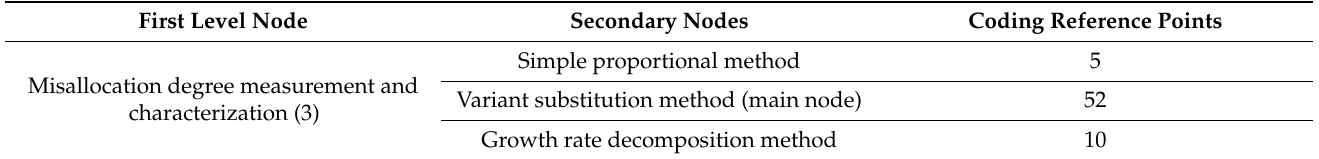
Table 7. Number of nodes at all levels and coding reference points included in the misallocation degree measurement and characterization